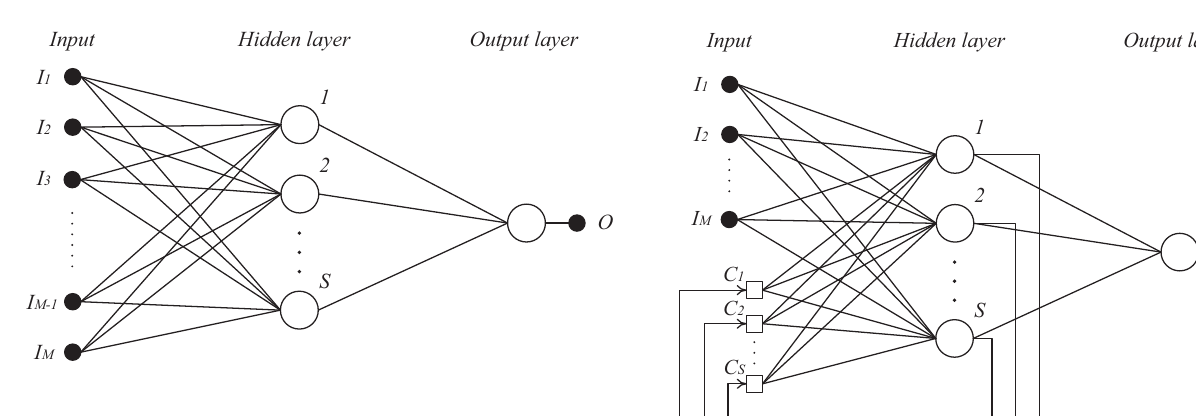
Fig. 2. Architecture of two-layer back-propagation neural network.